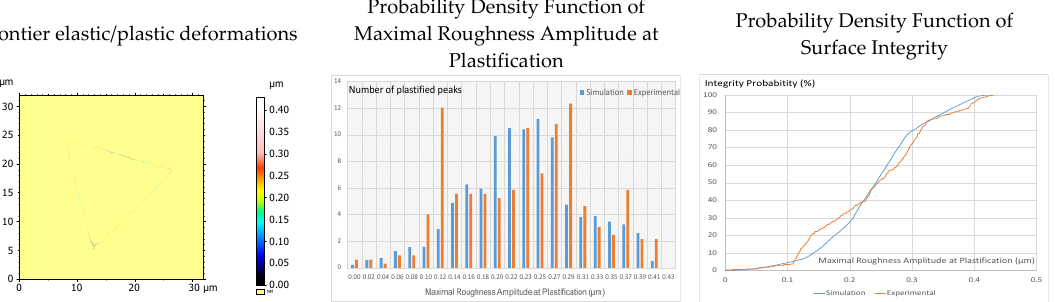
Figure 11. Frontier elastic/plastic deformations from elasto-plastic simulation of TA6V material ( left ). Probability density function of maximal roughness amplitude at plastification obtained from both simulated and experimental nano-indentations ( center ). Probability density function of surface integrity ( right ). 100% of integrity means that pass over a maximal peak amplitude of 0.43 µm, no plastification will occur).